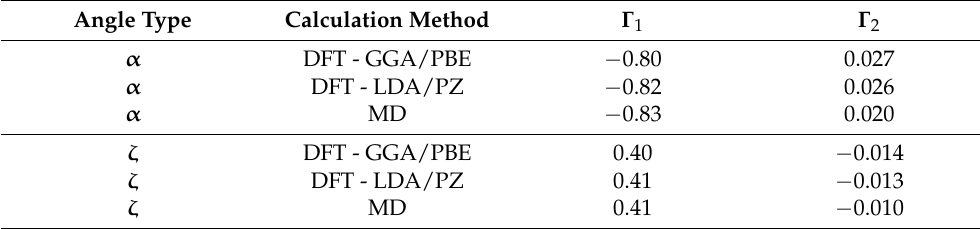
Table 3. Coefficients Γ 1 [in deg/(%strain)] and Γ 2 [in deg/(%strain) 2 ] of the strain dependence of the angles [see Equation (2)] for the bond angles of type α and ζ , when the strain is applied along the armchair direction, as obtained by the results of the different theoretical methods used in this work.